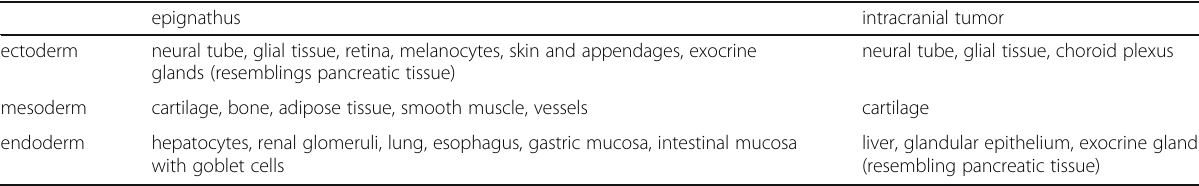
neural tube, glial tissue, choroid plexus liver, glandular epithelium, exocrine glands (resembling pancreatic tissue)